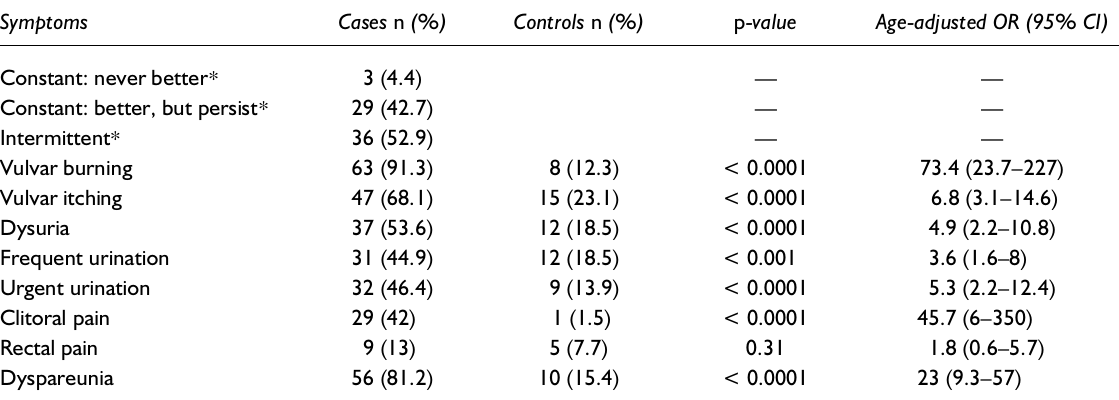
Table 4 VVS-related symptoms prior to diagnosis or clinic